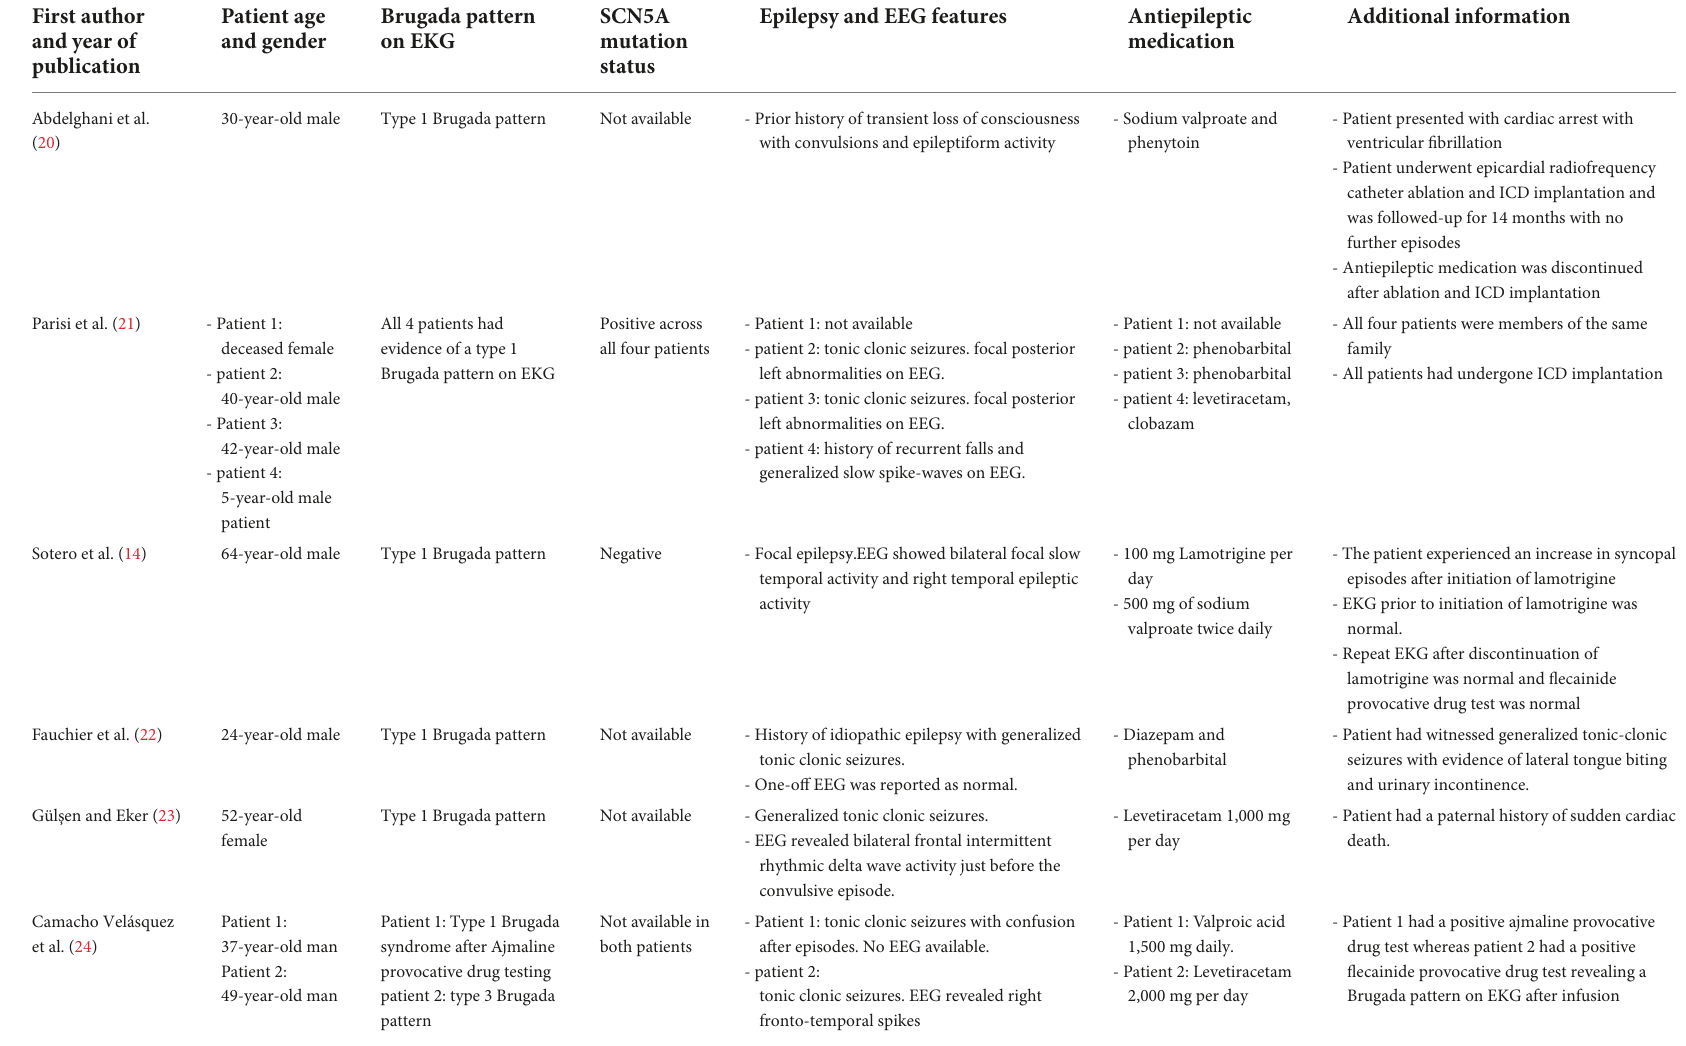
TABLE 1 Characteristic features of seventeen publications reporting the association between epilepsy and Brugada